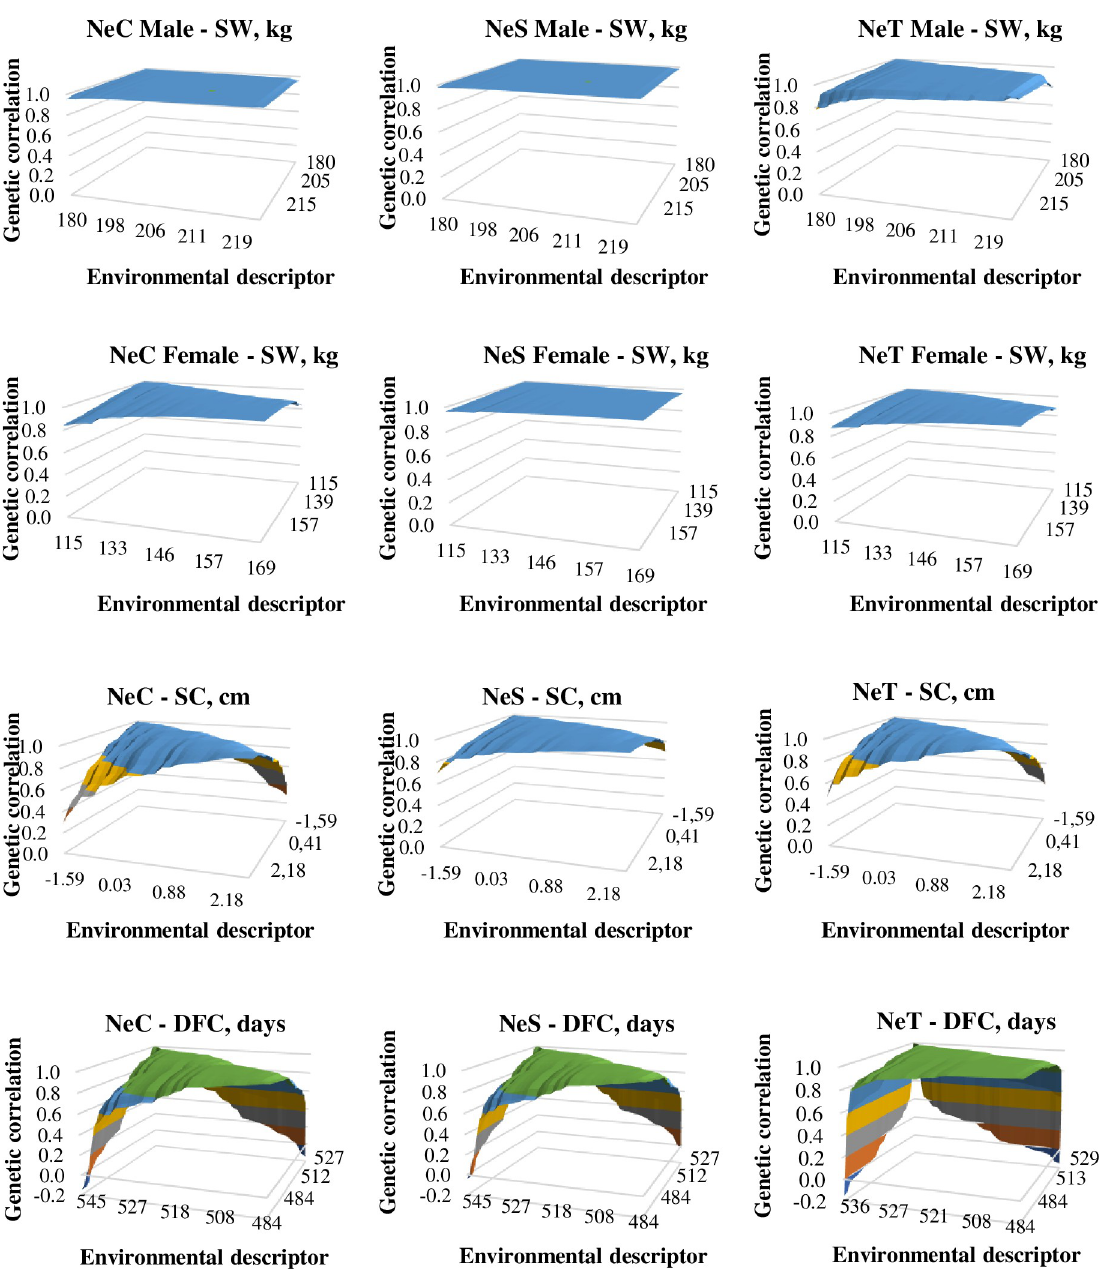
Fig 2. Genetic correlations between Selection Weight (SW, kg) of males and females, Scrotal Circumference (SC, cm), and Days at First Calving (DFC, days) along the environmental descriptor in three Nellore cattle lines (NeC, control; NeS, selection; and NeT,